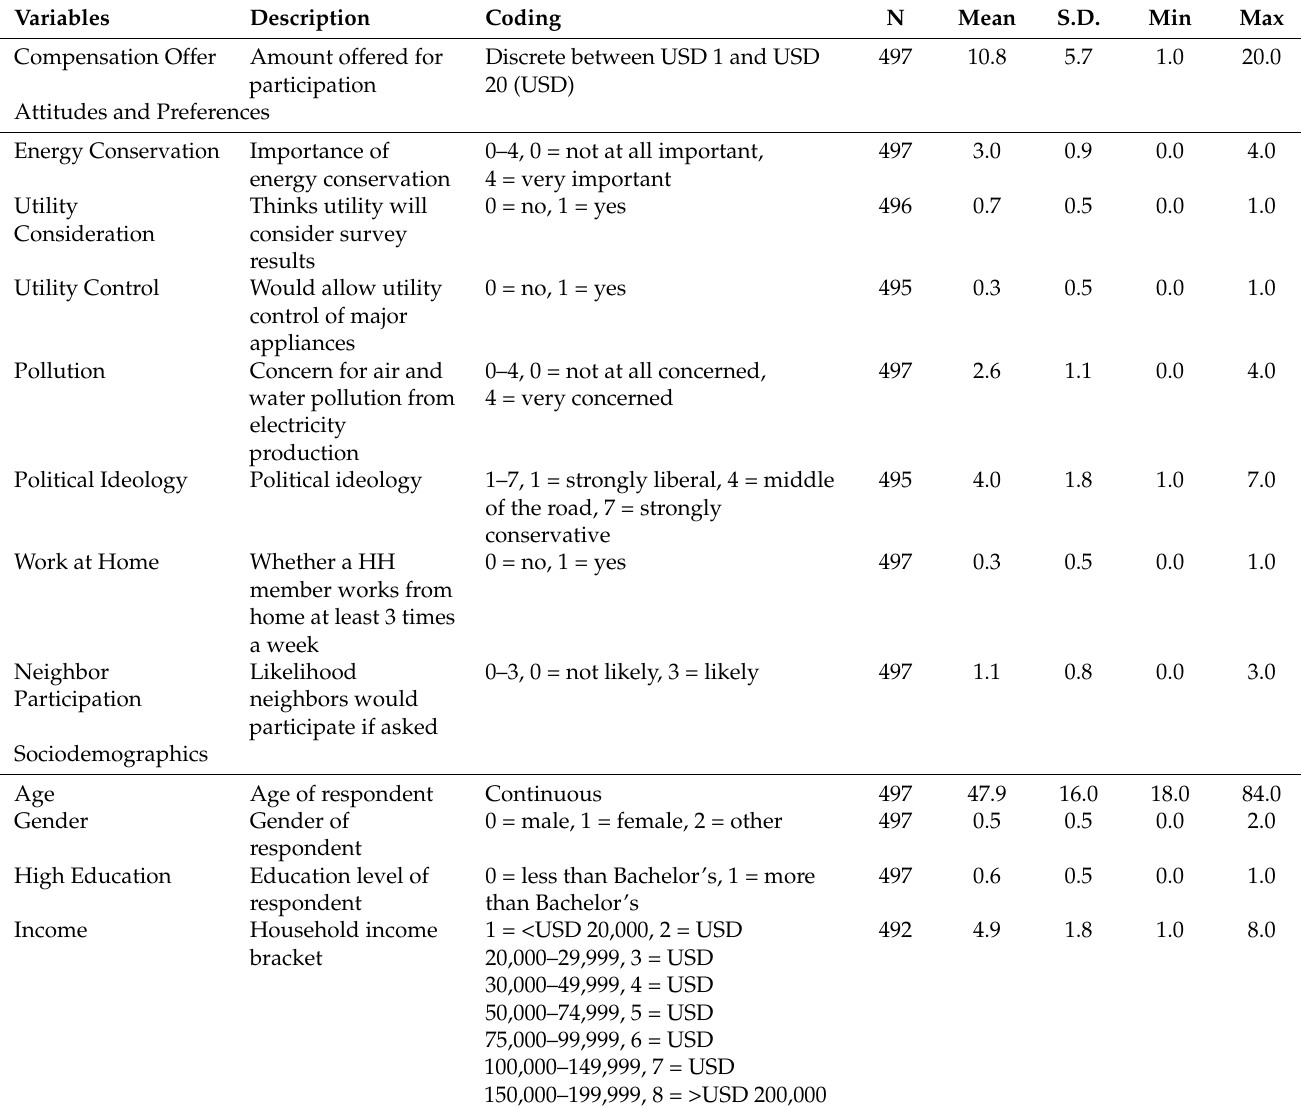
Table 2. Summary statistics of